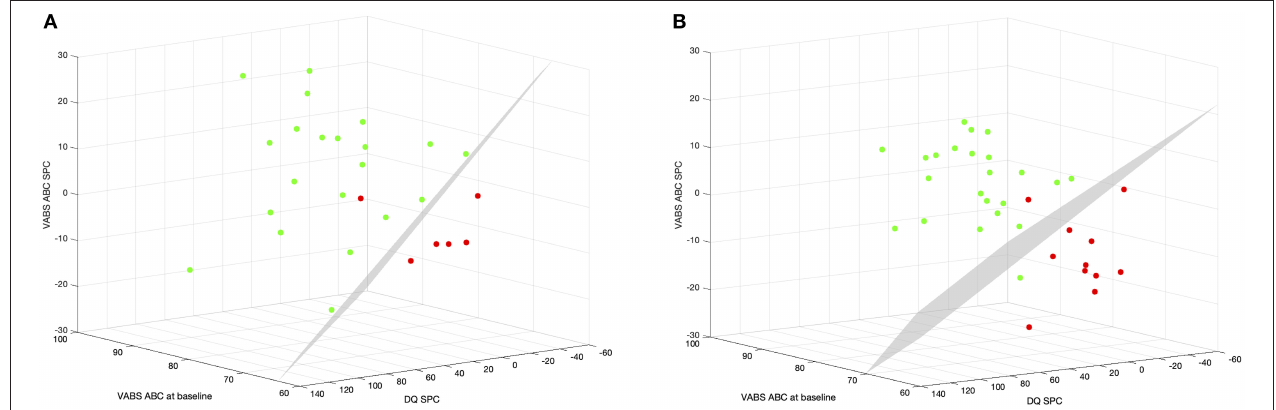
FIGURE 4 | (A) Multinomial logistic regression between MinR and OptR using their rates of change within the 6 first months of intervention in Composite DQ and VABS-II ABC, as well as their VABS-II ABC at baseline. Color code corresponds to subgroup membership (red: MinR, green: OptR). Decision boundary is represented in a dotted line. (B) Multinomial logistic regression between MinR and OptR using their rates of change within the 12 first months of intervention in Composite DQ and VABS ABC, as well as their VABS-II ABC at baseline. ABC, Adaptive behavior composite; DQ, developmental quotient; SPC, Symmetrized percent change; VABS-II, Vineland adaptive behavior